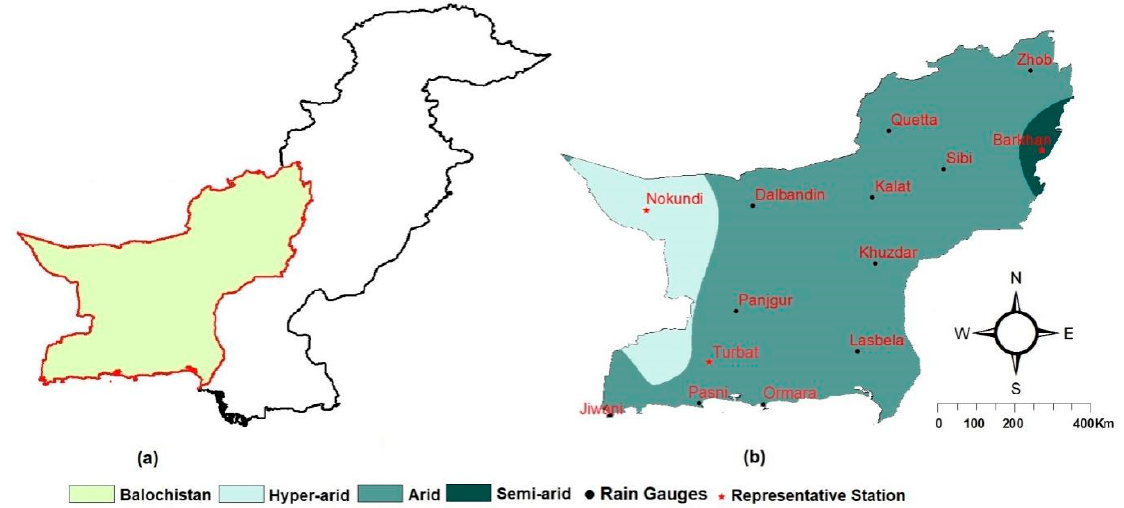
Figure 1. ( a ) The Balochistan Province in the map of Pakistan. ( b ) The location of rain gauges in different climatic zones of Balochistan.